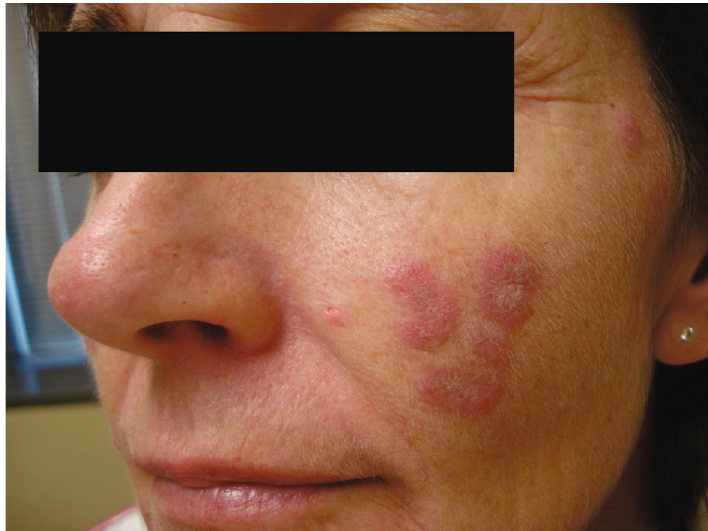
Figure 5: Coin-shaped erythematous plaques seen on this female patient ’ s left cheek, biopsy results consistent with discoid lupus.